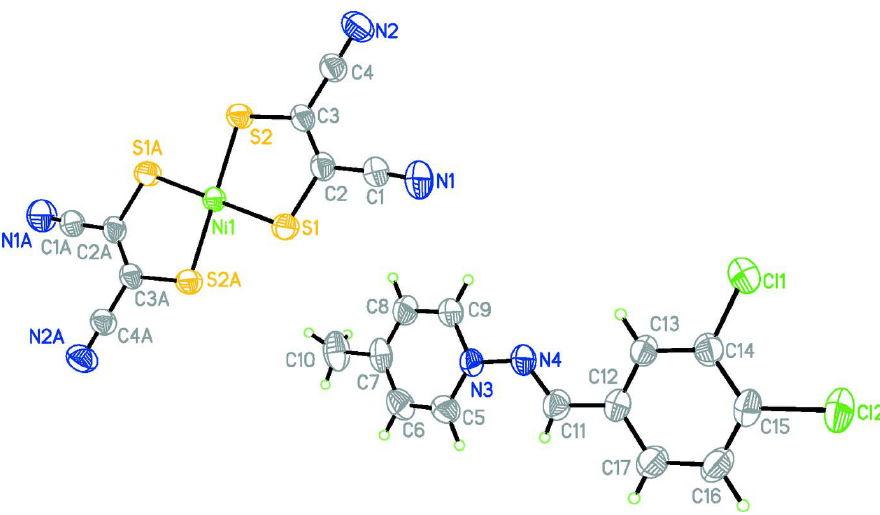
Figure 1 The molecular structure of the title molecule, with the atom-numbering scheme. Displacement ellipsoids are drawn at the